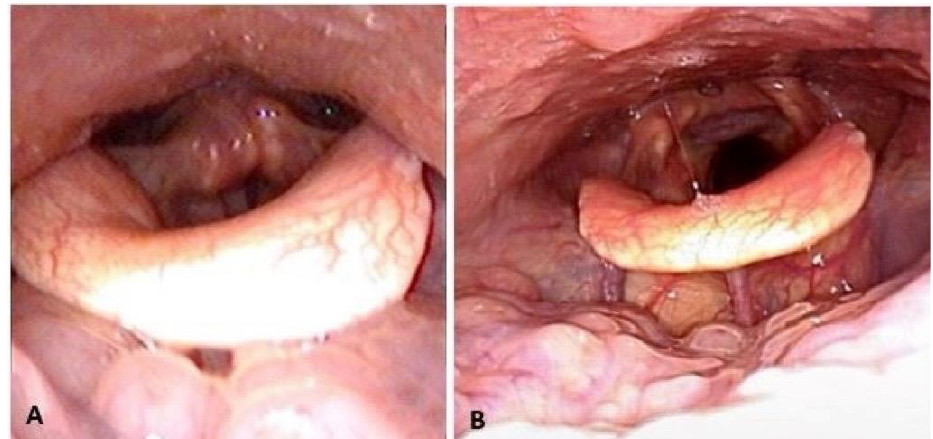
Figure 5. Change of airspace before ( A ) and after ( B ) transoral tongue suspension in fiberoptic na- sopharyngoscopy.